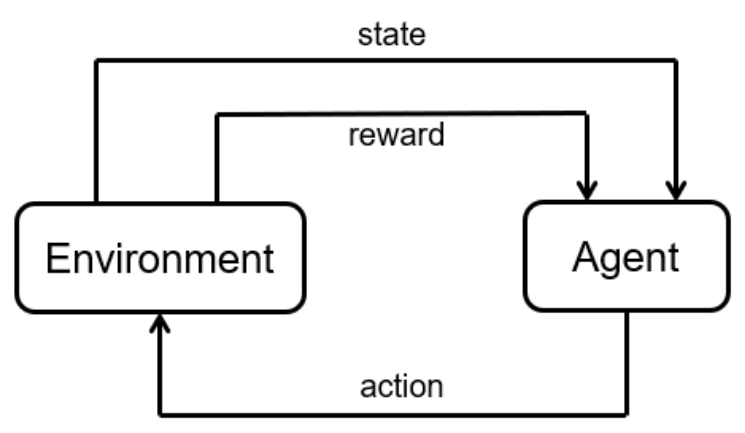
Figure 2. Schematic representation of reinforcement